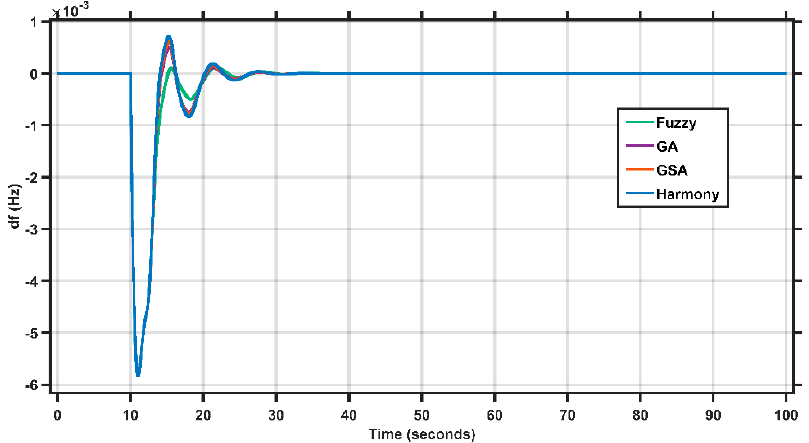
Figure 10. The frequency deviation under step disturbance.